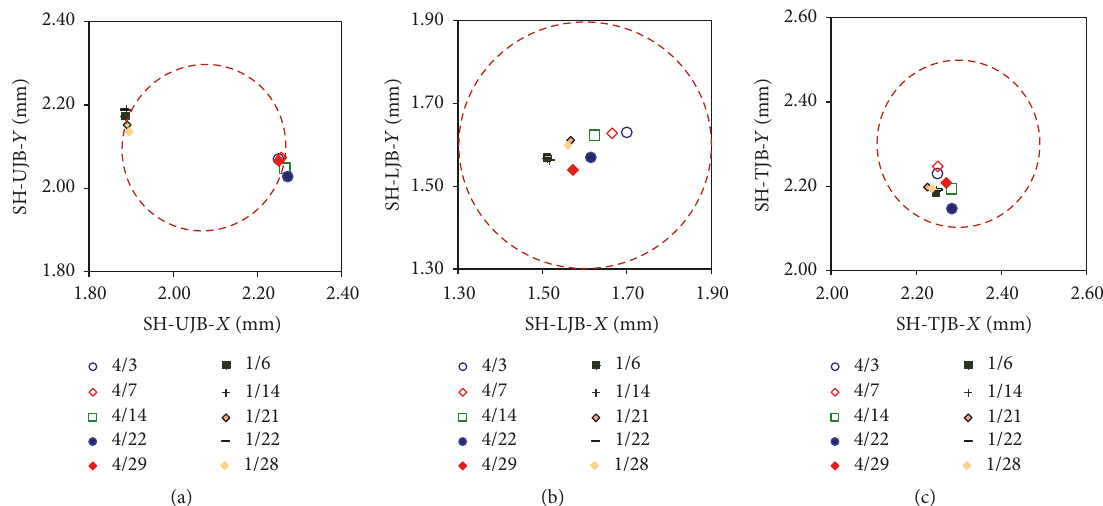
Figure 3: Shaft eccentricity in the upper (a), lower (b), and turbine (c) journal bearings of a 700 MW hydrogenerator, measured for several months.